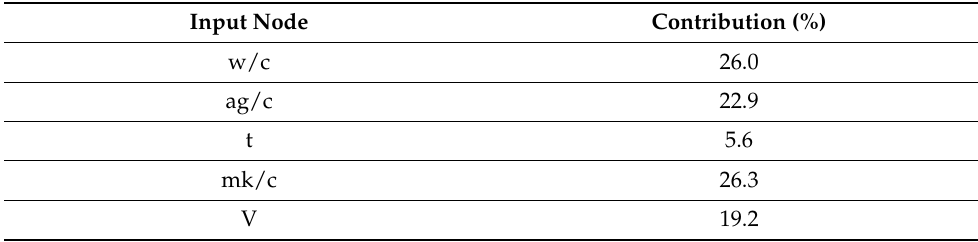
Table 5. Contribution of input node to